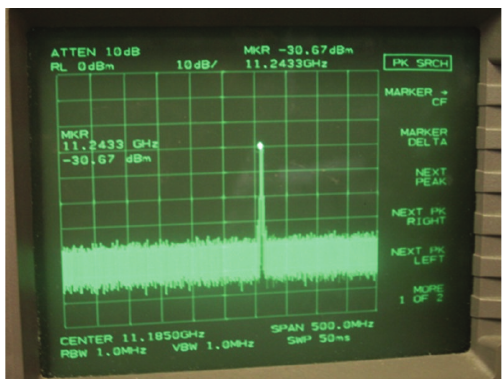
Figure 11: Output frequency versus V tune